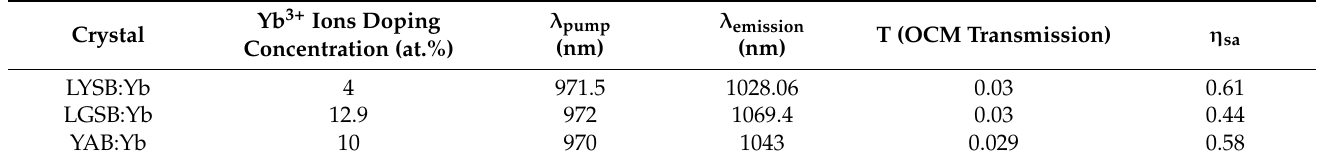
Table 12. Laser emission characteristics in quasi-CW operation of uncoated LYSB:Yb, LGSB:Yb, [44,46], and YAB:Yb [49] crystals. Yb 3+ Ions Crystal